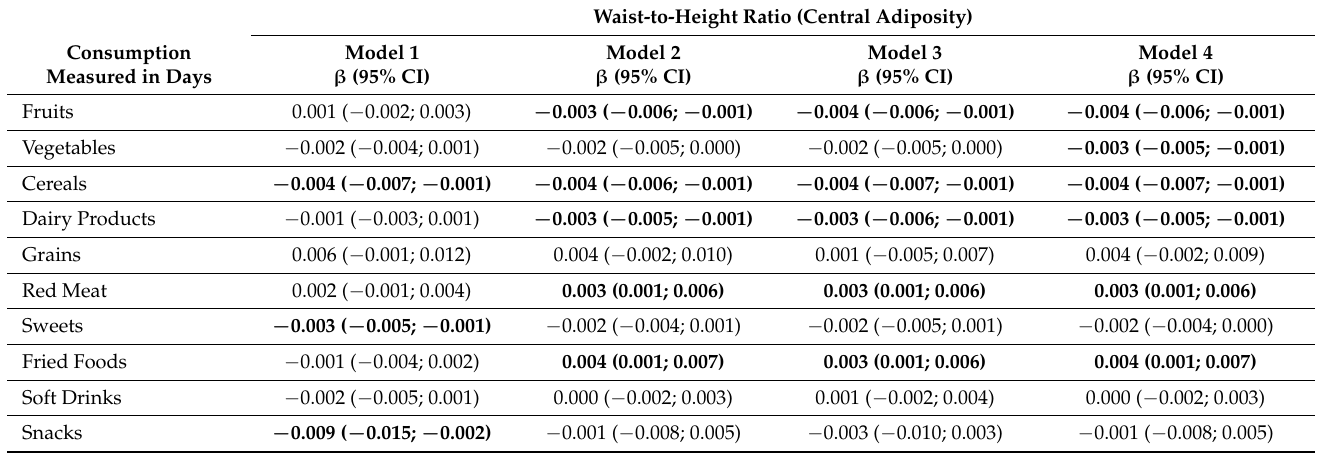
Table 3. Associations between waist-to-height ratio (central adiposity) and dietary patterns in adults. Waist-to-Height Ratio (Central